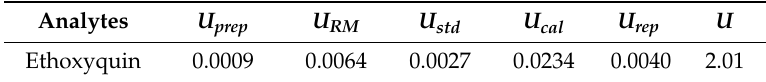
Table 6. Individual uncertainties of the sample preparation ( U prep ), reference material ( U RM ), standard stock solution ( U std ), calibration curve ( U cal ), repeatability ( U rep ), and expanded uncertainty ( U ) in accordance with the EURACHEM